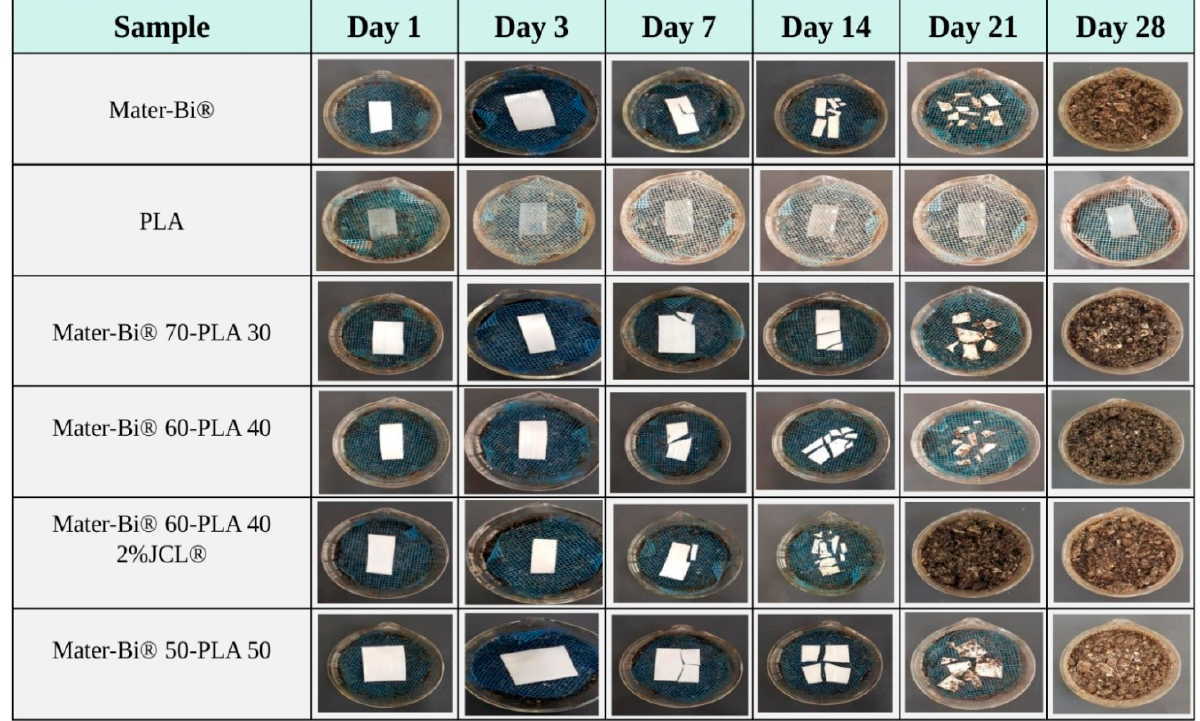
Figure 8. Macroscopic appearance of biodegradation in compost with 50% moisture at 58 °C.